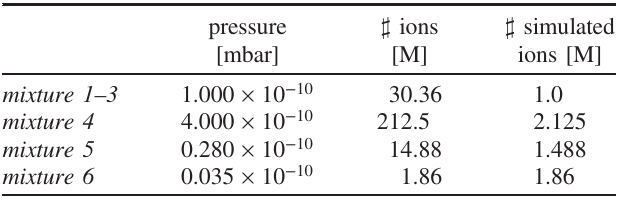
TABLE III. Pressures of residual gas and resulting number of ions per